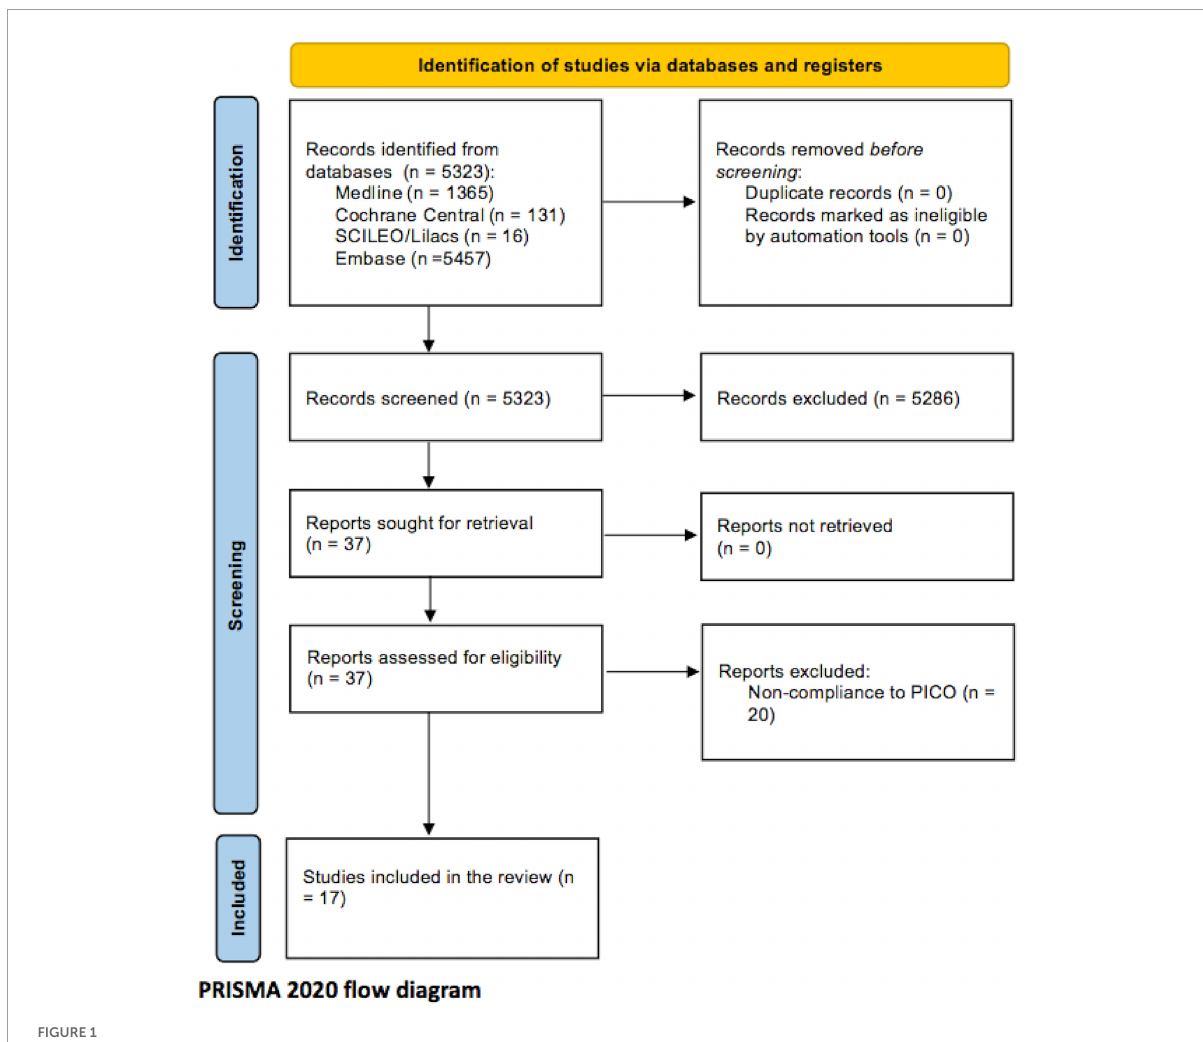
FIGURE1 Selection flow